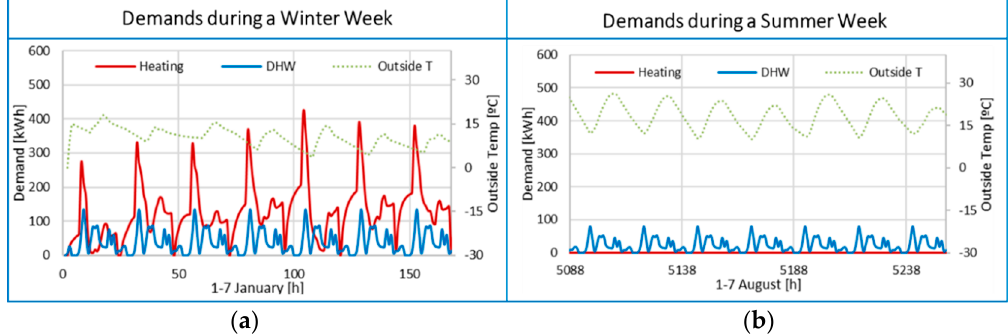
Figure 5 Heating and DHW demands and outside temperature during ( a ) a winter week and ( b ) a summer